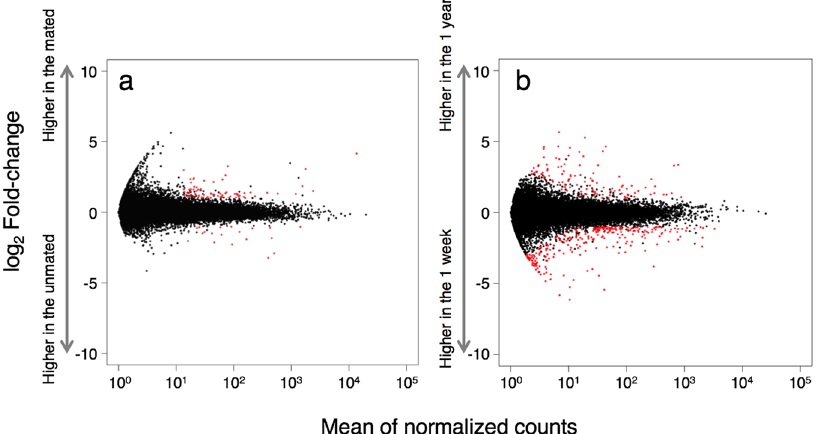
Figure 3. Plots of differentially expressed genes between the spermathecae of inseminated vs. virgin ant queens ( a ) and between the spermathecae at 1 week and 1 year after mating ( b ). Red dots indicate differentially expressed genes (FDR < 0.01 and |log 2 fold change| ≥ 1).